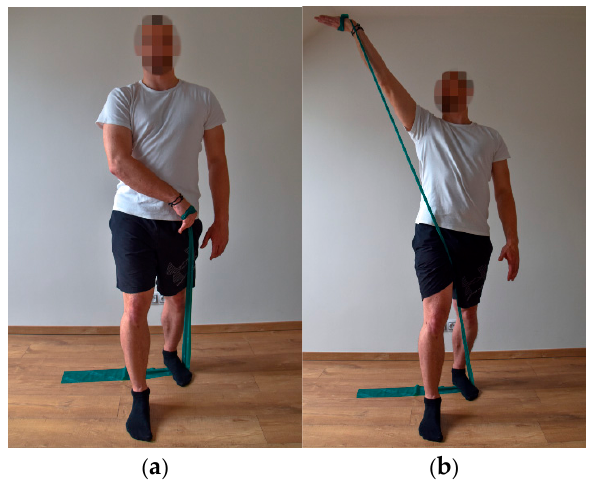
Figure 2. Second flexion diagonal—starting position ( a ) and end position ( b ).